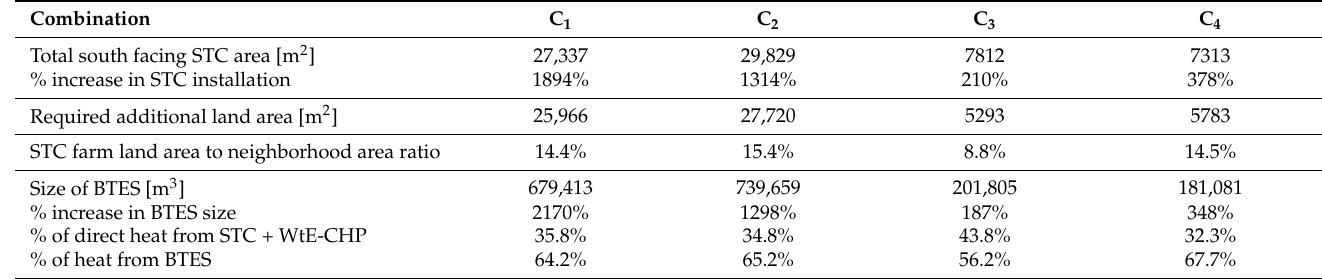
Table 5. Modified thermal energy resource to attain net zero energy